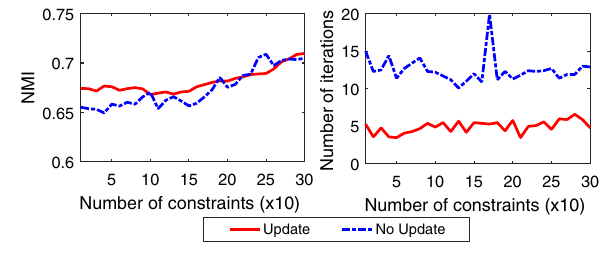
Fig. 10 Update versus fully reclustering for the Ecoli dataset